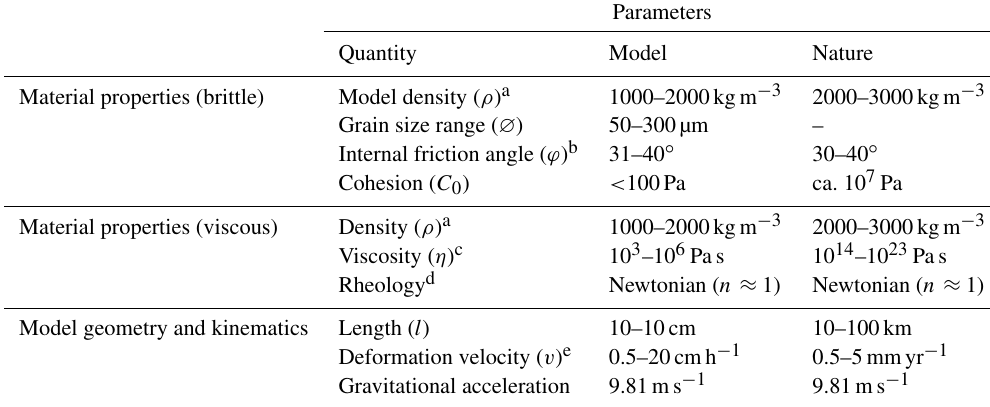
Table 1. Typical scaling parameters applied for analogue models of basin